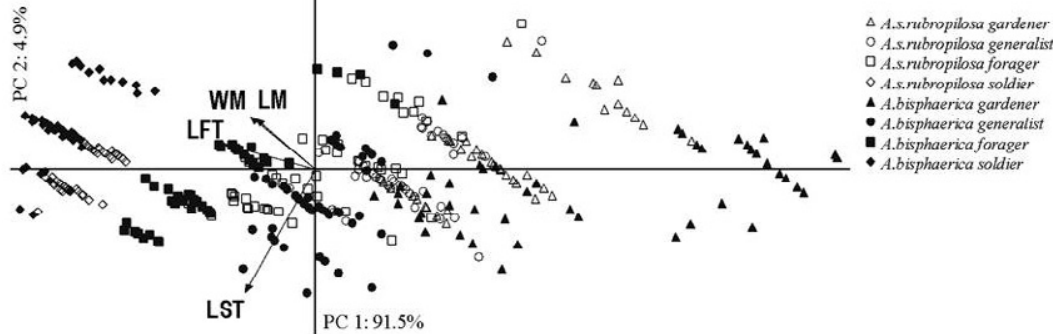
Fig 1 . Principal components analysis of mandible morphometric data of Atta sexdensrubropilosa and Atta bisphaerica in each worker caste for the variables width mandible (WM), Length mandible (LM) Length of the fisrt tooth (LFT) and length of the second tooth (LST) First two principal components (PCs) are plotted with the proportion of variance explained by each component printed next to the axes